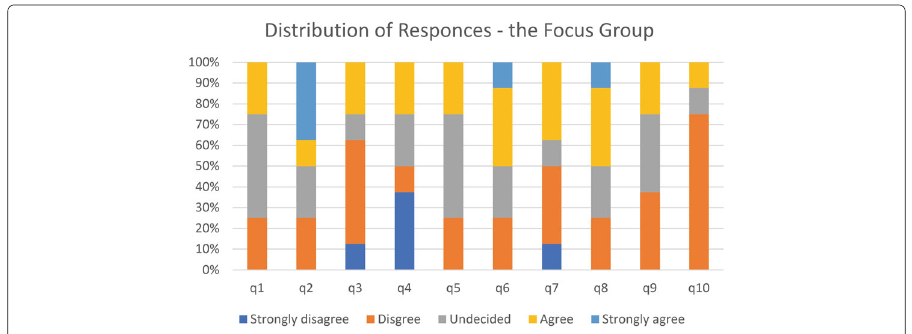
Fig. 8 Distribution of responses from the focus group